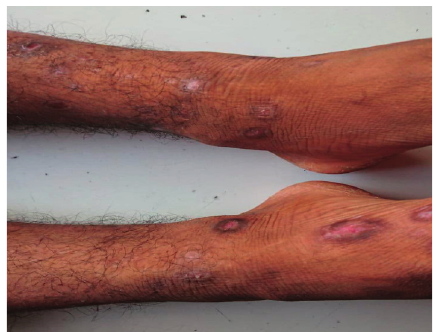
Figure 3: Multiple skin lesions with central hypopigmentation and perilesional